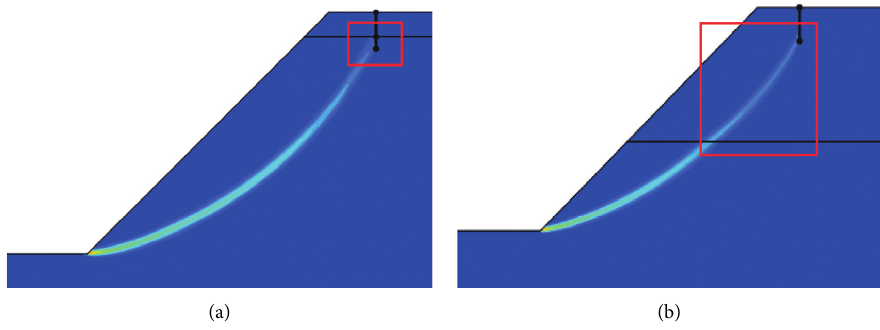
Figure 12: Failure surface at different thicknesses of top layer. (a) T / H � 0.1. (b) T / H �